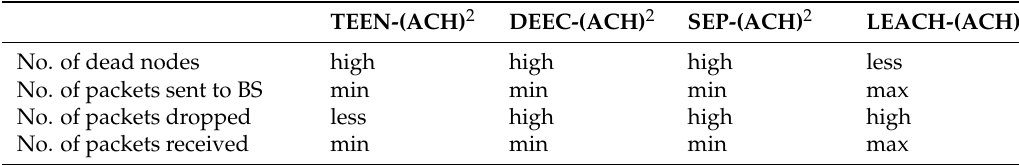
Table 4. Scenario-II: Performance of proposed schemes.